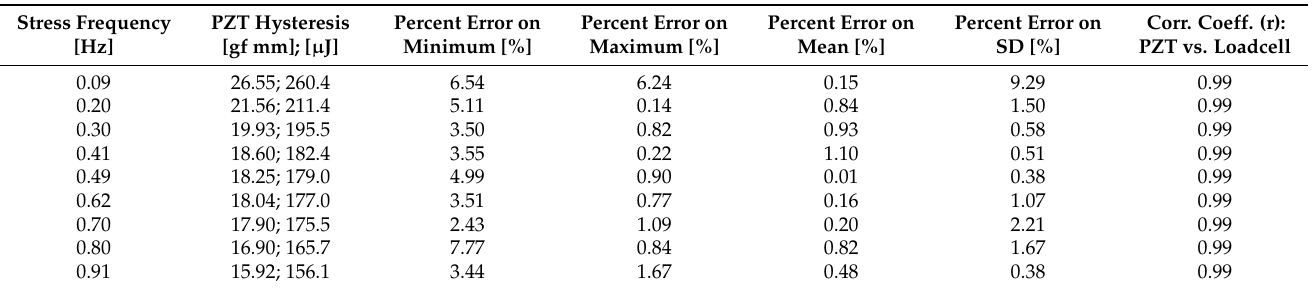
Table 4. Hysteresis of the PZT sensor, percent errors of the main descriptive statistics of measurements from PZT versus loadcell values, and correlation coefficients between the PZT and loadcell signals, computed for various stress frequencies.